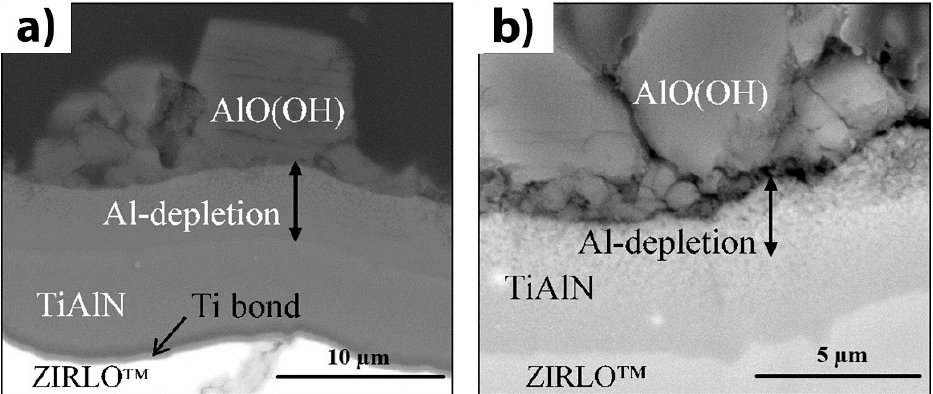
Figure 7. Cross-section SEM images of TiAlN/Ti/ZIRLO™ after autoclave testing at 360 °C for 72 h: ( a ) secondary electron mode, and ( b ) backscattered electron mode. Reproduced from [ 127 ] with permission by Elsevier.